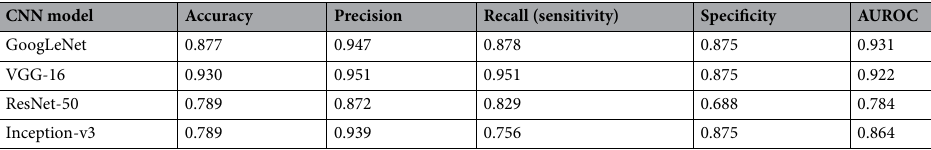
Table 1. The performance metrics of CNN models for the validation dataset images. AUROC, area under the receiver operating characteristic curve; CNN, convolutional neural network.